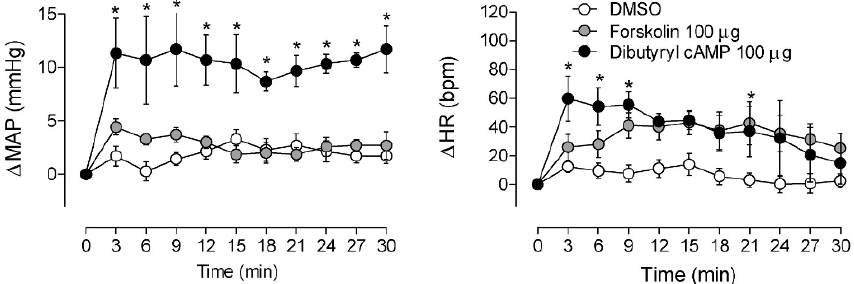
Figure 3 - Time course of the mean arterial pressure ( D MAP) and heart rate ( D HR) following the intrathecal administration of an adenylate cyclase agonist (forskolin), a cAMP analog (dibutyryl-cAMP) or the vehicle (DMSO). * p , 0.05 compared to